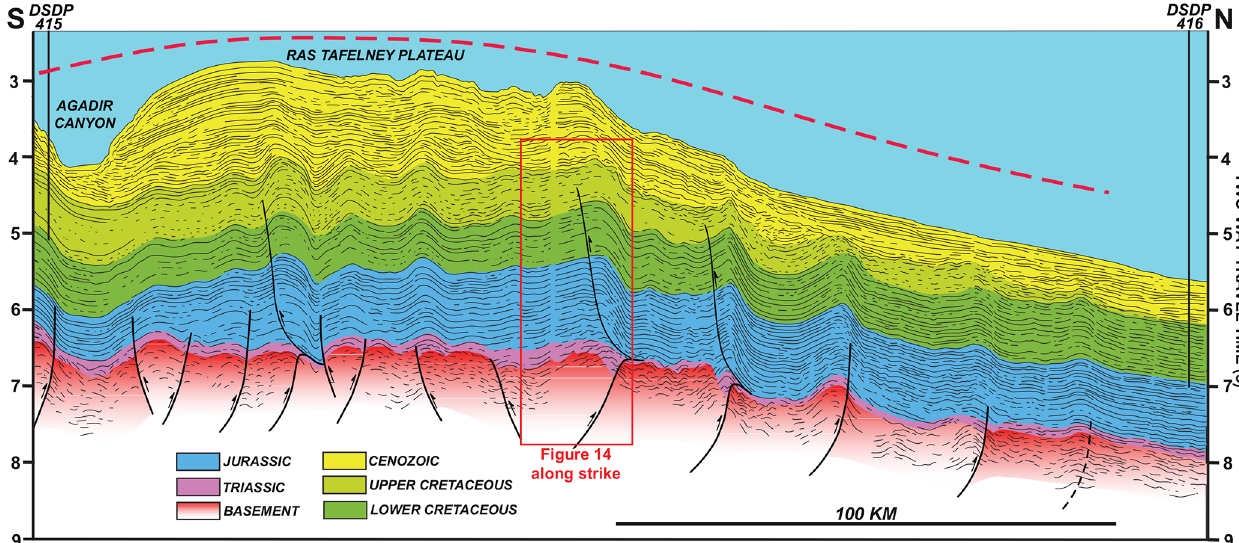
Figure 13. Line drawing interpretation of a composite regional 2D seismic transect adapted from Tari et al. (2012). Line drawing interpre- tation of a regional cross section connecting the DSDP 415 and 416 wells. Note the expression of middle to late Cenozoic inversion which is driven by the compressive reactivation of basement-involved normal faults and linked detachments within the Mesozoic basin cover. The dashed red line shows the regional for the upwarping of the offshore continuation of the Atlas system. The approximate location of a nearby industry 3D seismic section (Fig. 14) is highlighted by a red